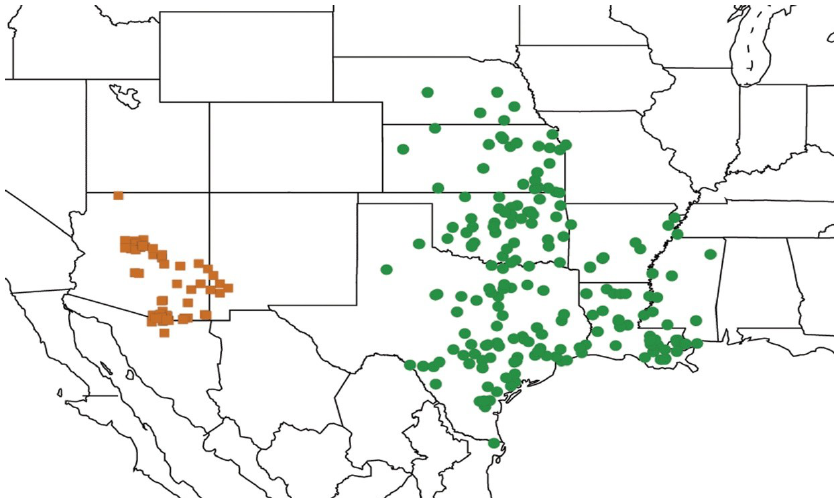
Figure 25. Distribution of cultriformis (orange squares) and T. resh (green circles).